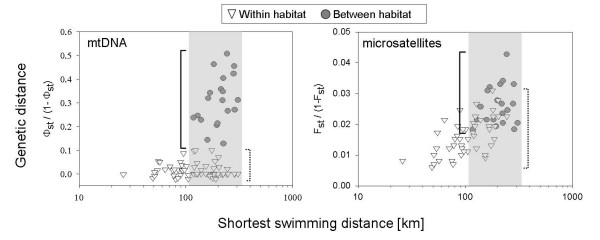
Relationship of geographic distance (logarithm of shortest swimming distance) and genetic distance of the mitochondrial (mtDNA) and nuclear marker (microsatellites). Triangles symbolize pair-wise comparisons between rookeries that share the same habitat. Filled circles stand for comparisons across habitats. The shaded area indicates the range of geographic distances that is characteristic for both intra- and inter-habitat specific pairwise comparisons. Dotted brackets visualise the value range of genetic distances from within habitat comparisons, solid brackets from between habitat comparisons.